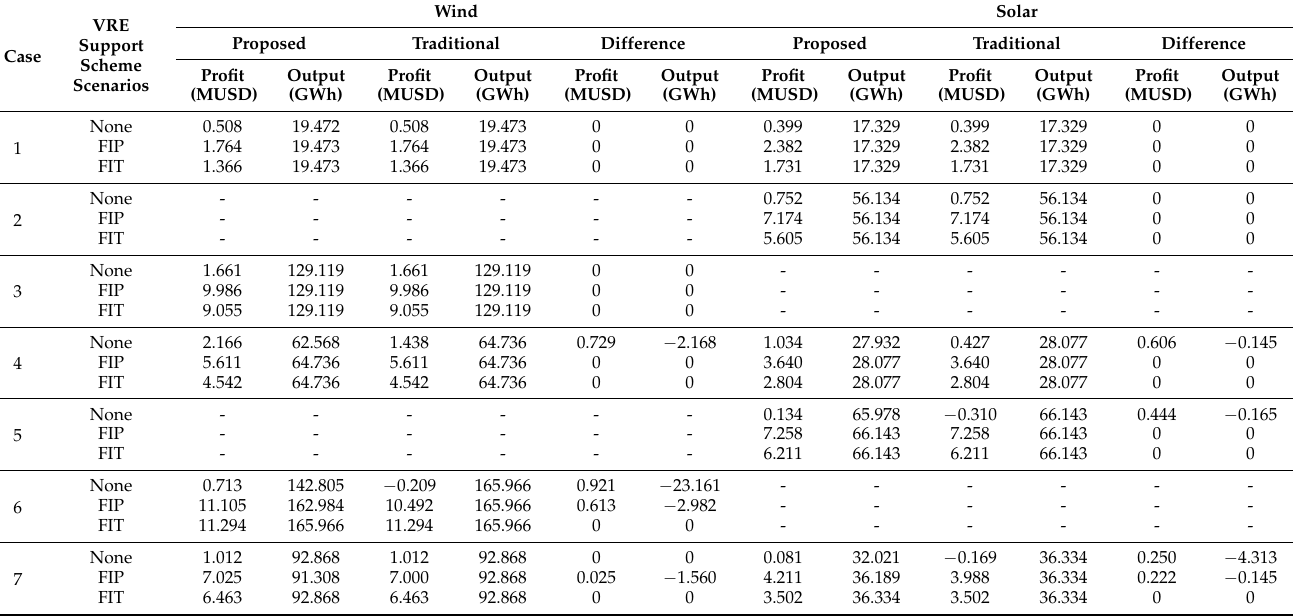
Table 5. The VRE generators’ daily profits and the output during a